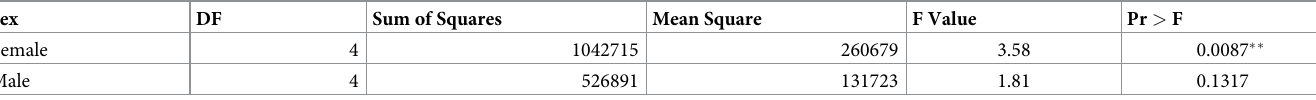
Table 3. Effect of cohort within each sex on TFF2 levels. Sex DF